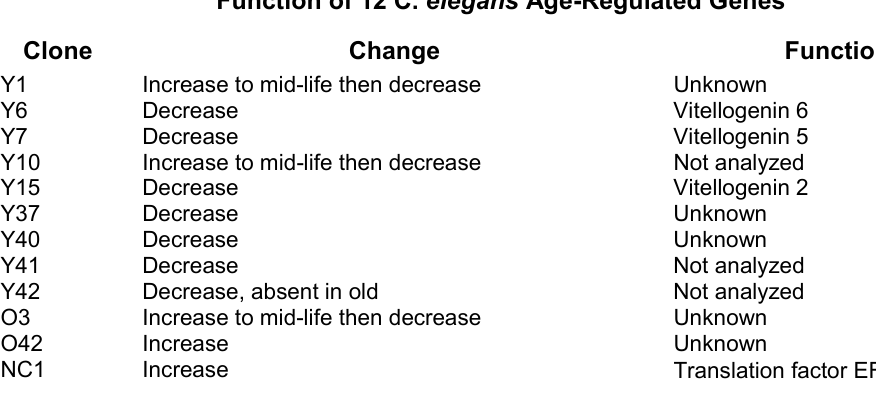
Function of 12 C. elegans Age-Regulated